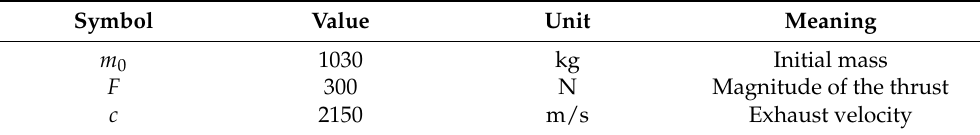
Table 3. Spacecraft